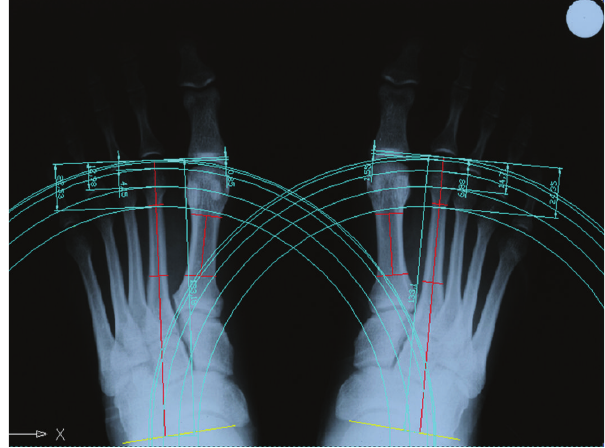
Figure 2: Values of metatarsal protrusion was measured as the distances between the arcs of circumference tangent to the most distal points of each metatarsal head and the most distal point of the head of MTT